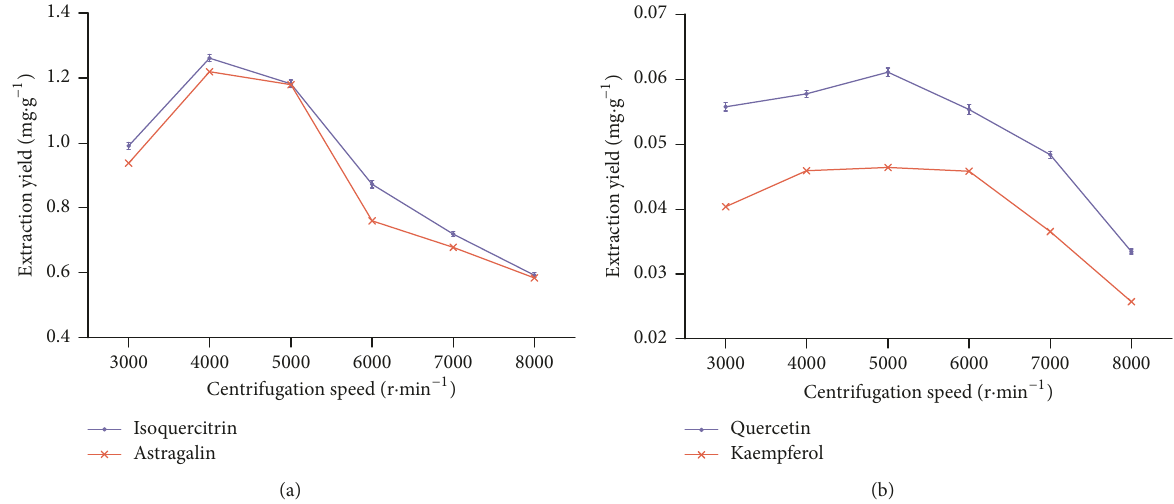
Figure 9: Effect of centrifugation speed on extraction yields. Type of IL: [BMIM]BF 4 ; concentration: 0.5 mol ⋅ L −1 ; the particle size: 24 mesh (a) and 40 mesh (b); solid-liquid ratio: 1:10 g ⋅ mL −1 (a) and 1:20 g ⋅ mL −1 (b); ultrasound time: 20 min (a) and 45 min (b); ultrasound power: 500